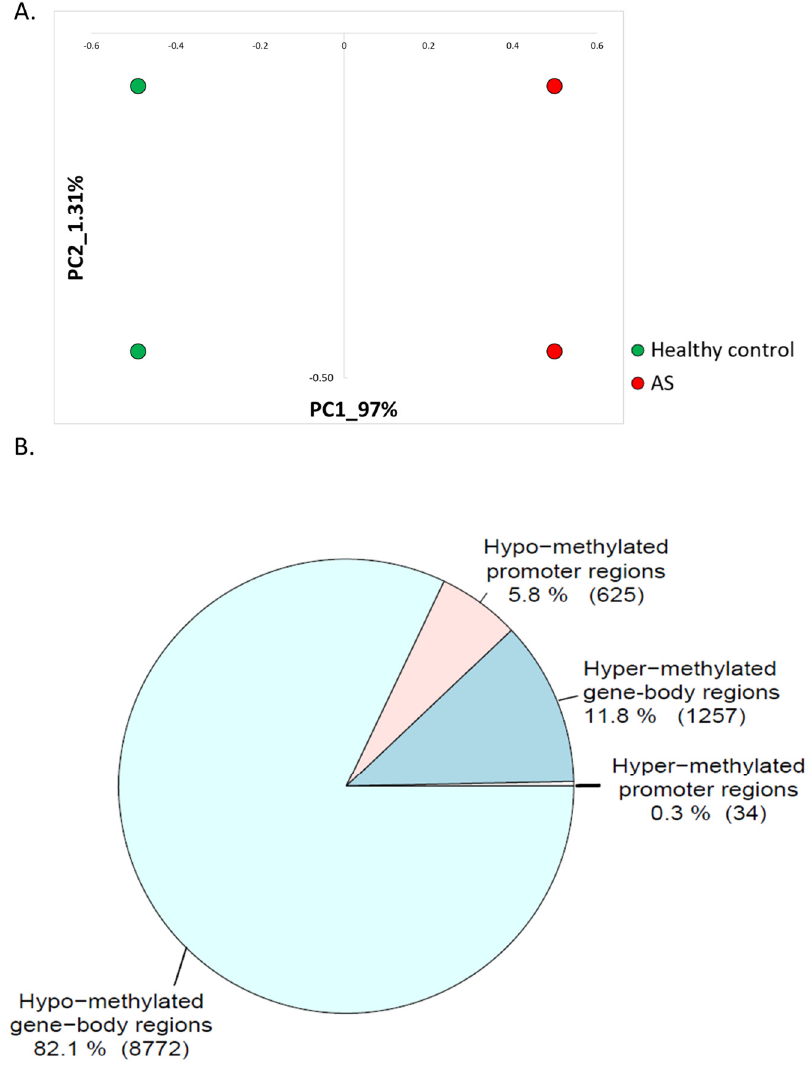
Figure 1. ( A ) Principal component analysis (PCA) of gene expression iPSC-derived neurons (PRJNA255989). ( B ) Pie chart showing the number of hyper-methylated regions near promoters (±1000 bp) (34 regions); hyper-methylated regions inside the gene bodies (1257 regions); hypo-meth- ylated regions near promoters (±1000 bp) (625 regions); and hypo-methylated regions inside gene- bodies (8772 regions).